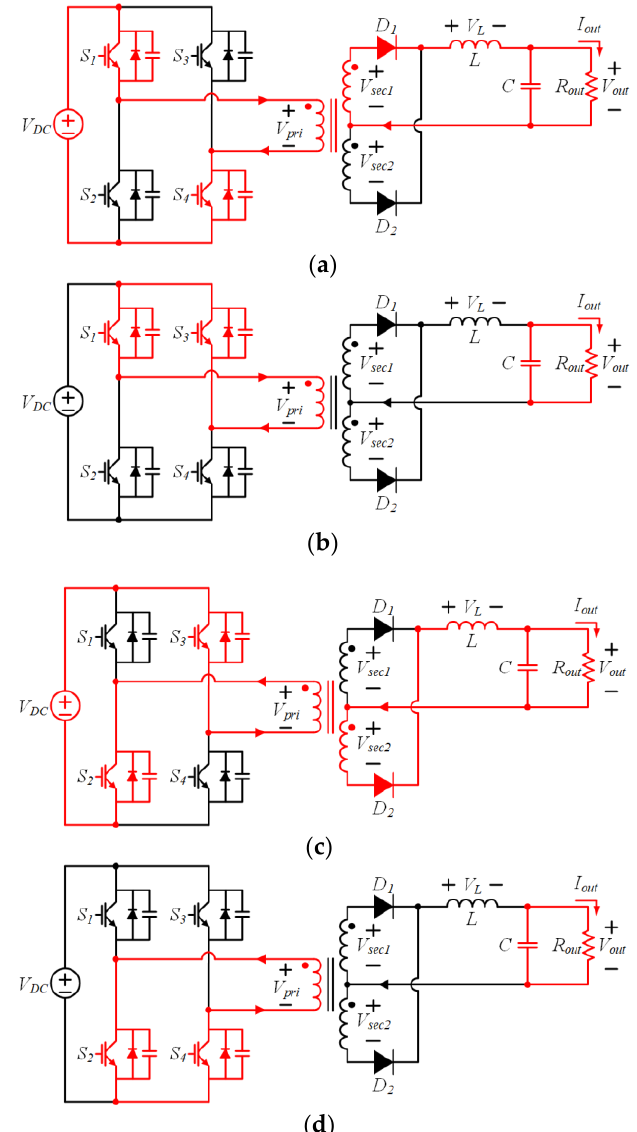
Figure 2. Equivalent circuits of the PSFB-CT converter depending on the operation of switches. ( a ) Mode 1; ( b ) Mode 2; ( c ) Mode 3; ( d ) Mode 4.